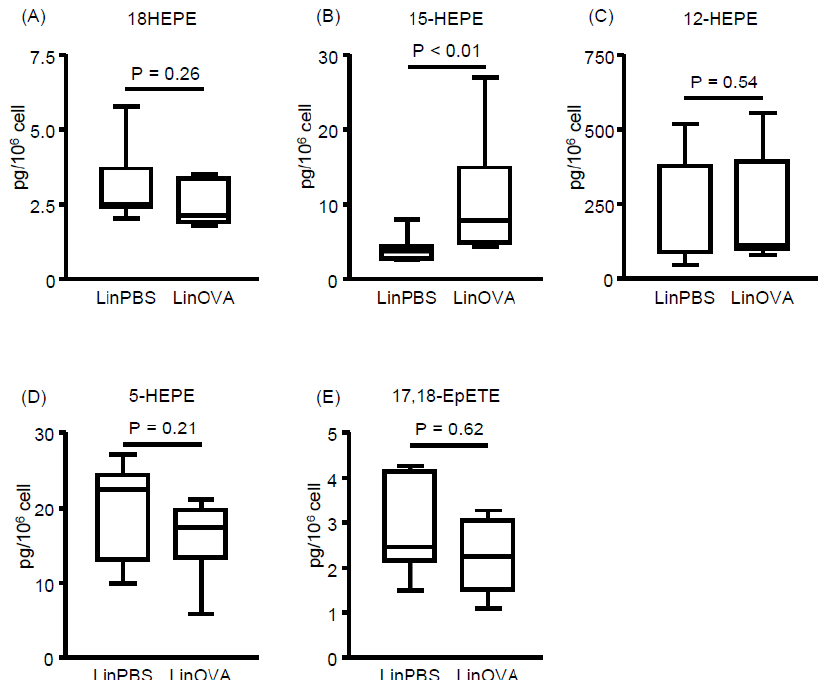
Figure 3. Induction of allergic rhinitis influences fatty acid metabolism in nasal passages. ( A–E ) EPA-derived fatty acid metabolites including ( A ) 18-hydroxyeicosapentaenoic acid (HEPE), ( B ) 15-HEPE, ( C ) 12-HEPE, ( D ) 5-HEPE, and ( E ) 17,18-epoxyeicosatetraenoic acid (17,18-EpETE) in nasal passages were analyzed by using LC–MS/MS. Data are from two independent experiments ( n = 7). Center values indicate medians. Statistical significance between two groups was calculated by using the Mann–Whitney U test.